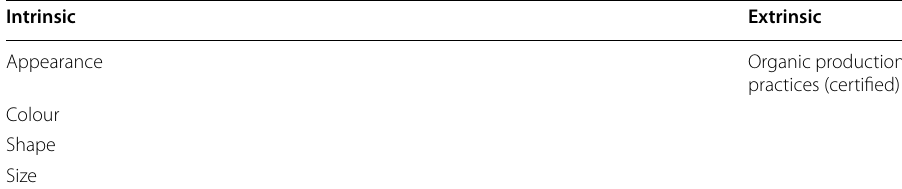
Table 1 Intrinsic and extrinsic vegetable quality attributes